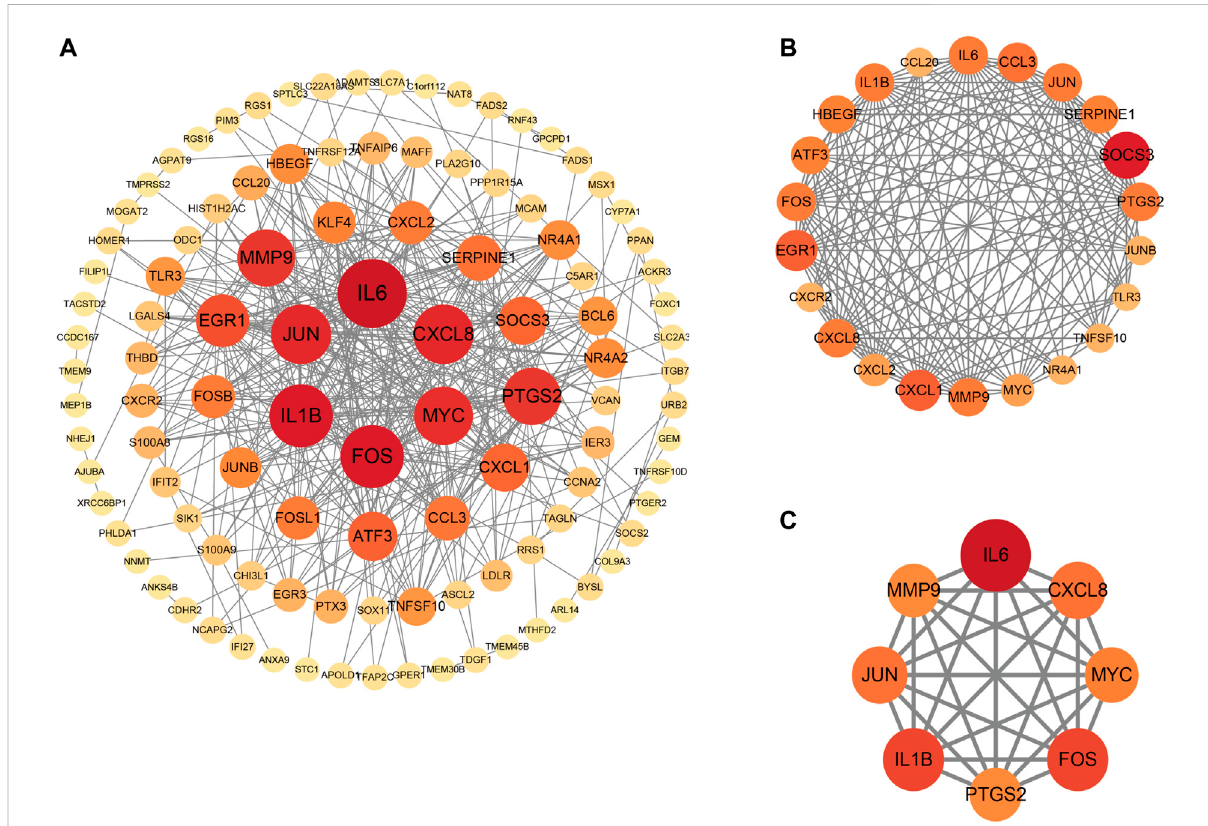
FIGURE 6 Protein-protein interaction (PPI) networks. (A) , PPI of 147 shared genes between NAFLD and CRC identi fi ed. (B) , the regions most densely connected as identi fi ed by the MCODE plugin. (C) , 8 hub genes were ascertained with 7 different algorithms of cytoHubba. Corresponding to the nodes, the size and color of each gene is based on the degree of interaction.